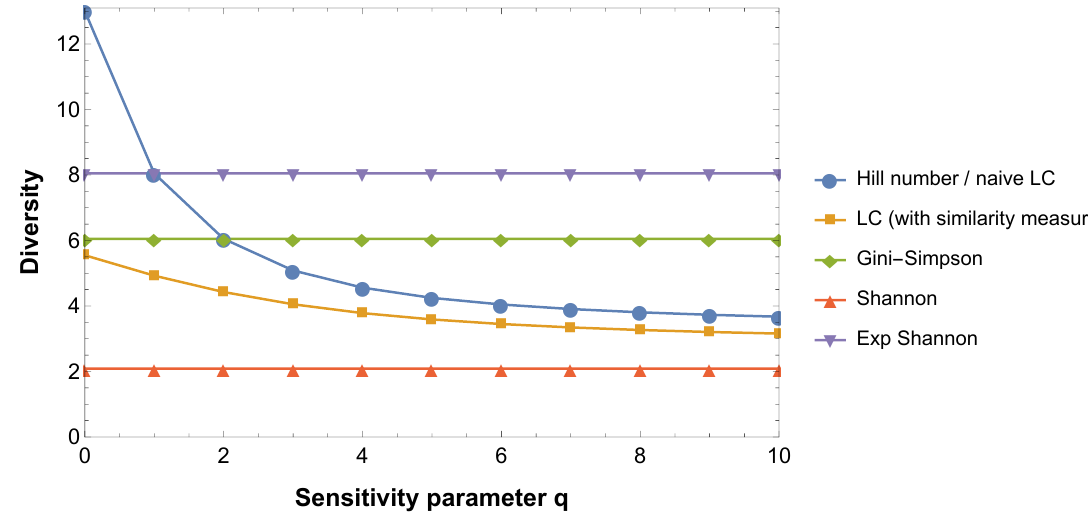
Figure 2. Comparison of diversity indices for a community given by the species abundance vector ( 0.0407,0.179,0.0144,0.00403,0.31,0.00858,0.109,0.0643,0.0999,0.021,0.0638,0.0184,0.0677 ) . Parametric families of indices (Hill numbers and Leinster-Cobbold index family) result in profiles, while univariate indices are not functions of q .